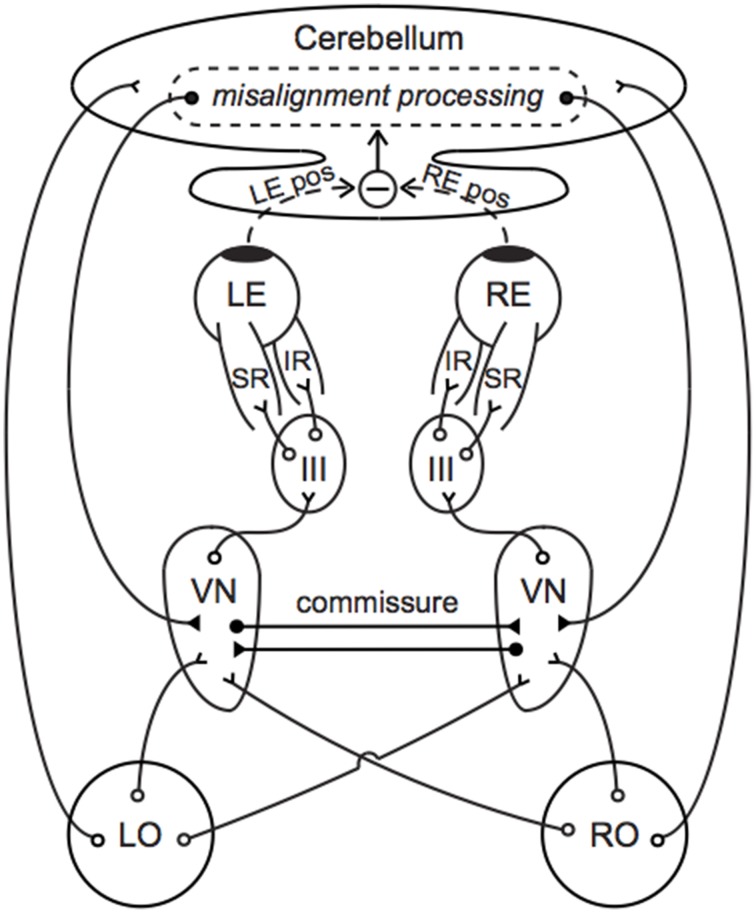
Neural compensation for an otolith asymmetry manifest as a vertical ocular positioning misalignment. Primary afferents synapse in the VN, which project to III to control contraction of the SR and IR. The cerebellum compares the left and right eye positions and sends compensatory signals back to the VN. Commissural connections between the left and right VN improve the sensitivity of otolith-mediated reflexes and may further aid in compensation. Direct projections between the end organs and cerebellum facilitate an immediate transmission of the current GIA. Open circles indicate excitatory pathways and filled circles indicate inhibitory pathways. LO, left otolith; RO, right otolith; VN, vestibular nucleus; III, oculomotor nucleus; LE, left eye; RE, right eye; LE pos, left eye position; RE pos, right eye position.